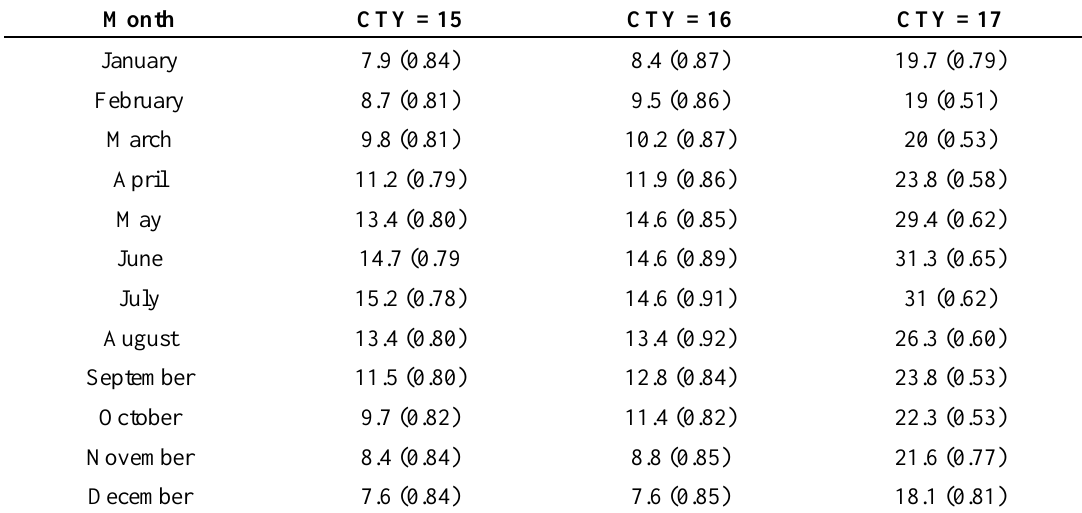
Table 1. Solar elevation angle thresholds (degrees) for cloud classes 15, 16, and 17 for each month of 2008. In brackets are the associated explained variances for the linear regression between SID and the corresponding solar elevation Norm